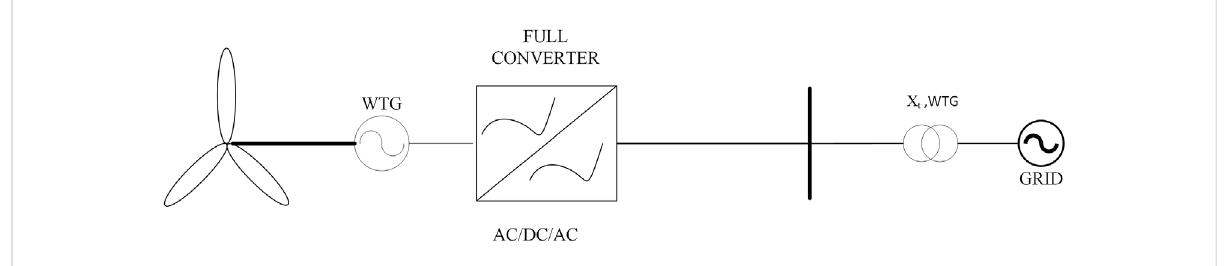
FIGURE 7 Wind turbine with full